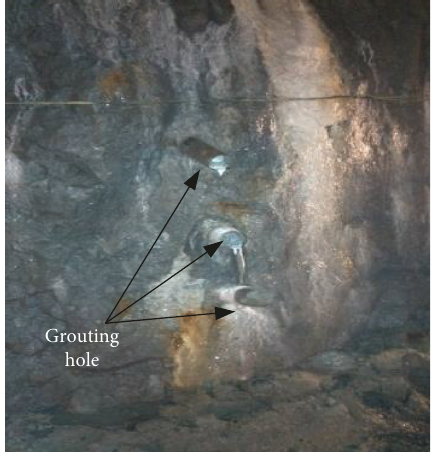
Figure 11: Grouting reinforcement.